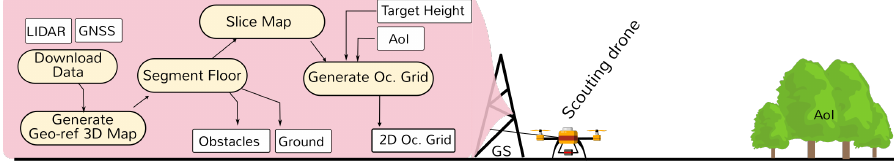
Figure 3. Scouting phase—post-processing: from LIDAR data to 2D Navigation